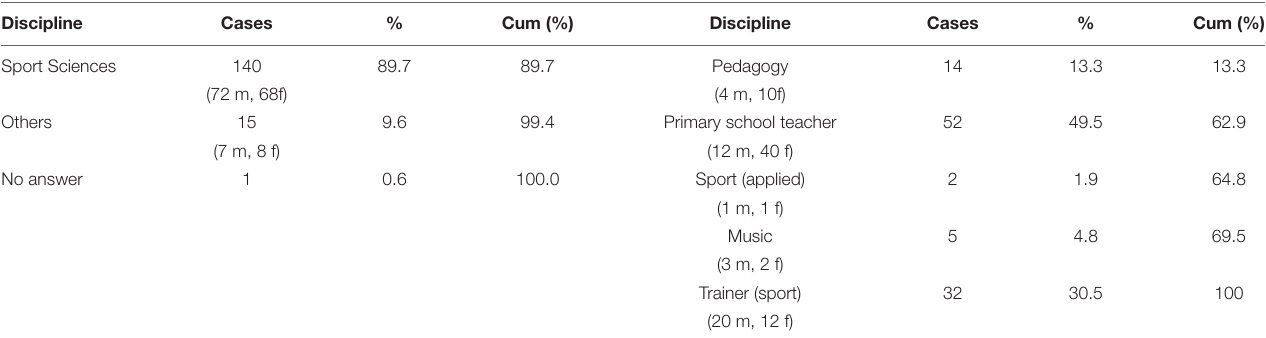
TABLE 1 | Student distribution by study